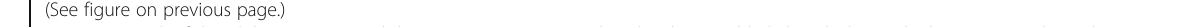
The red triangles are the microRNAs, the yellow ovals represent the globin proteins, while the blue round rectangles are other proteins. The width of the edge represents the confidence score where the bold solid lines are > 0.9 while normal solid are > 0.7. MicroRNA interactions are represented by dashed lines. Bold genes in the table are those validated as targets of the corresponding miRNA